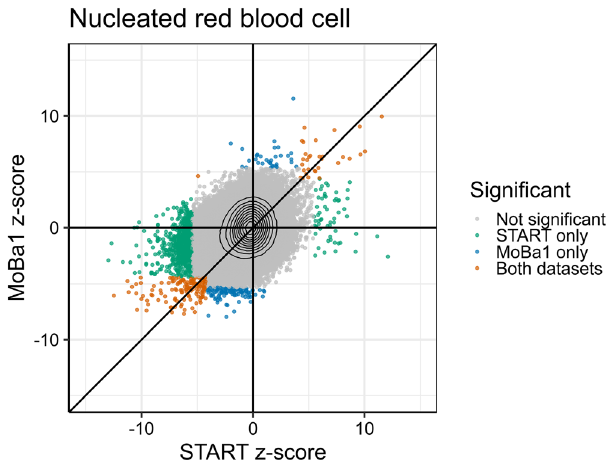
Fig. 4 Comparison of nRBC-speci fi c CpGs associated with GA in the EPIC-based START dataset ( n = 953) and the 450k-based MoBa1 dataset ( n = 1062). Gray dots indicate nonsigni fi cant CpGs, blue dots CpGs signi fi cantly associated only in MoBa1 ( p B < 0.05), green dots CpGs signi fi cantly associated only in START ( p B < 0.05), and orange dots CpGs signi fi cantly associated in both datasets ( r < 0.05). Black isolines indicate the density of the points, increasing towards the crossing point of the axes. The x and y axes represent z -scores (i.e., the coef fi cient estimate divided by the standard error) for START and MoBa1,